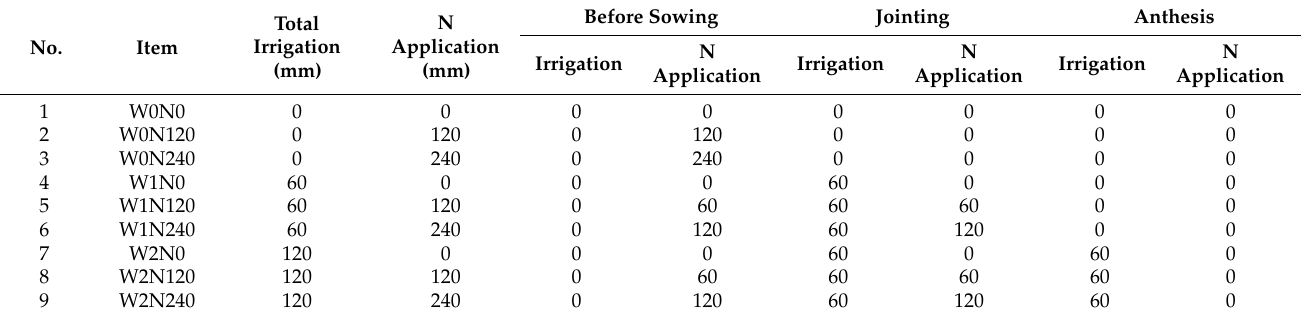
Table 1. Experiments on the irrigation and nitrogen application for winter wheat at Xinji city (2015–2017).